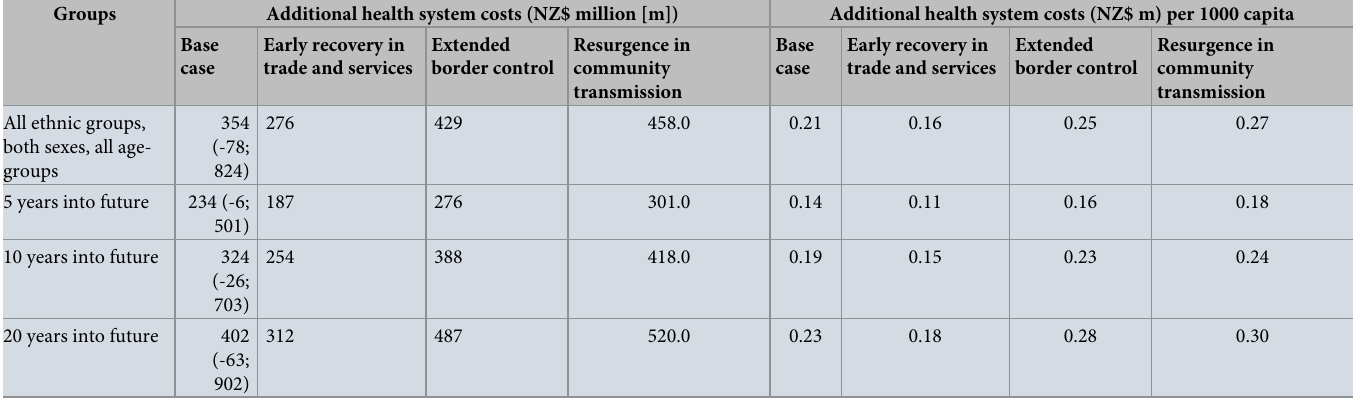
Table 5. Additional health system costs for the base case (most likely unemployment scenario) (3% discount rate for the remaining life of the NZ population alive in 2011).